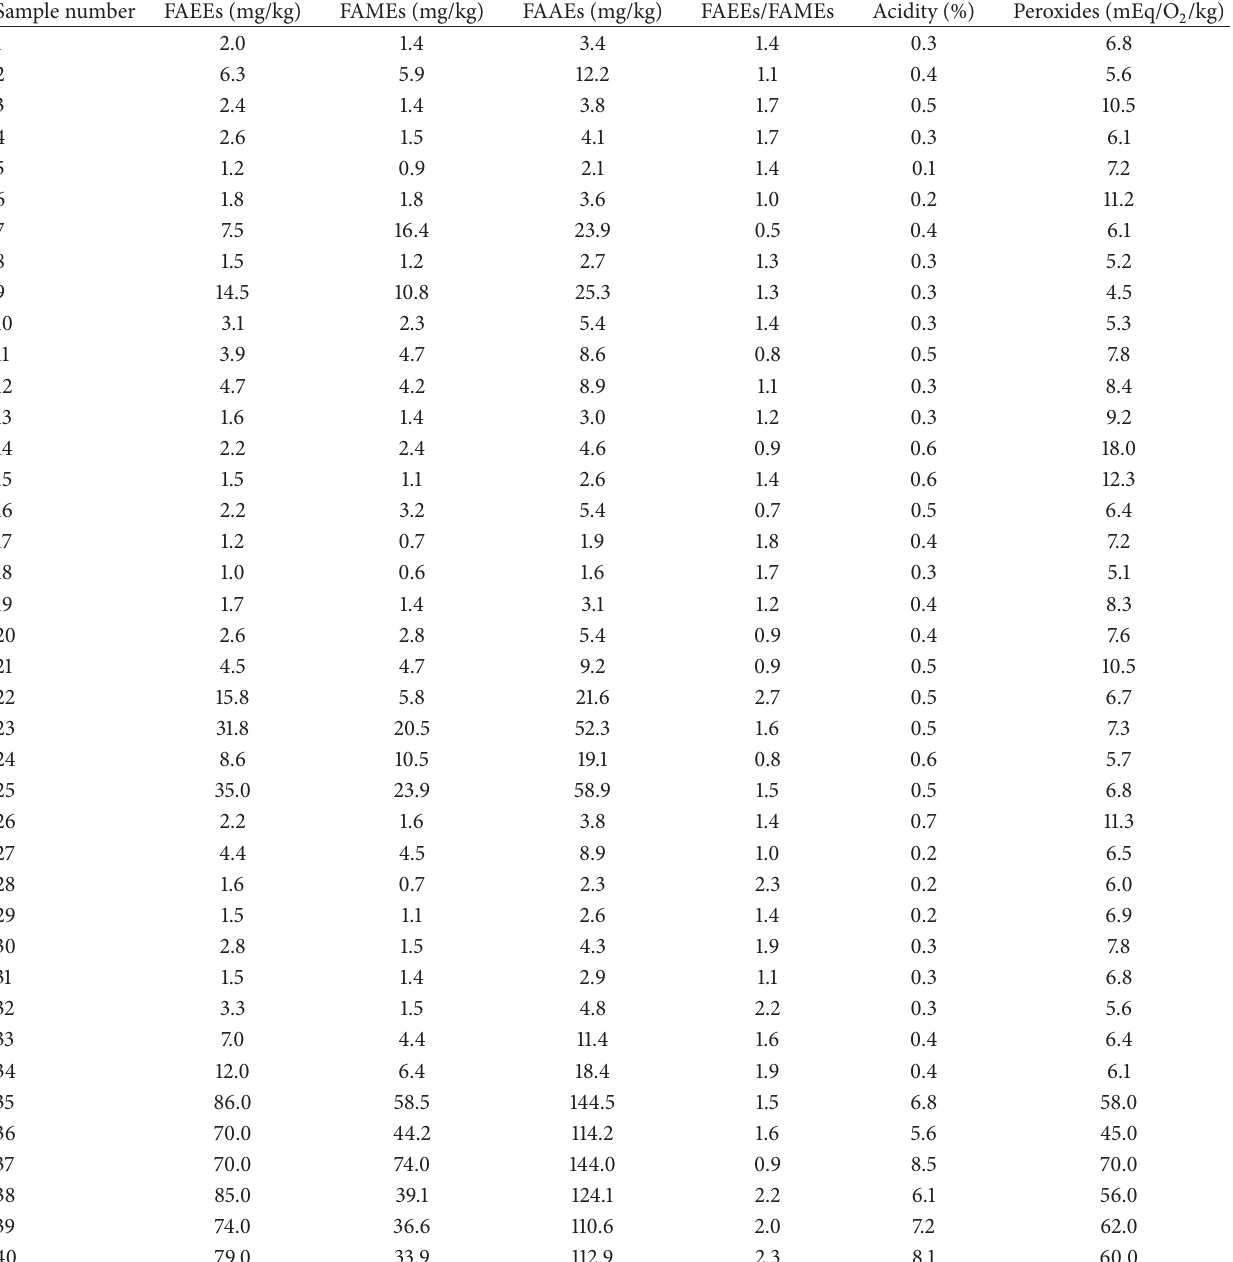
Table 2: Content of fatty acid alkyl esters (FAAEs), peroxide value, and free acidity in extra virgin olive oils. FAEEs: fatty acid ethyl esters; FAMEs: fatty acid methyl